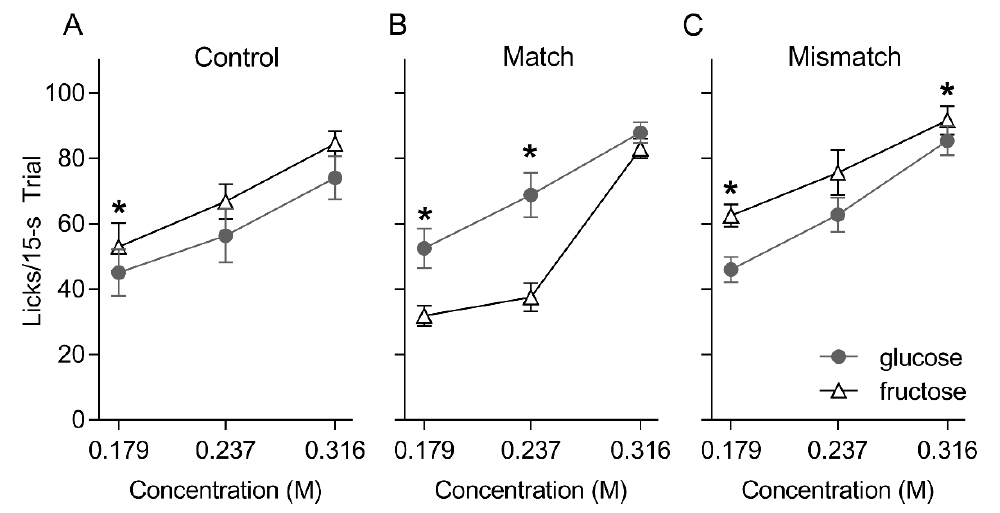
Figure 3. Mean ± SEM licks to three concentrations of glucose and fructose presented in randomized order in 15 s trials for the Control ( A ), Matched ( B ) and Mismatched ( C ) training groups during the post-conditioning brief access taste test. Asterisks (*) indicate significant pair-wise differences (glucose versus fructose).